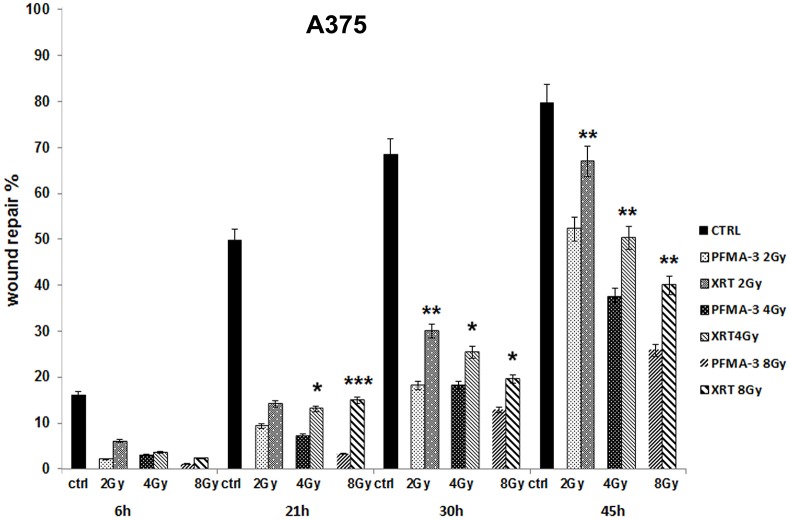
PFMA-3 affected A375 migration abilities more than XRT.Cell migration behaviour was evaluated during performance of a wound-healing assay after treatment with 2 Gy, 4 Gy and 8 Gy PFMA-3 and XRT. Data were representative of three independent experiments performed in quadruplicate. ctrl, control cells. Asterisks indicated statistically significant differences (*P <0.05, **P <0.005, ***P <0.0005).